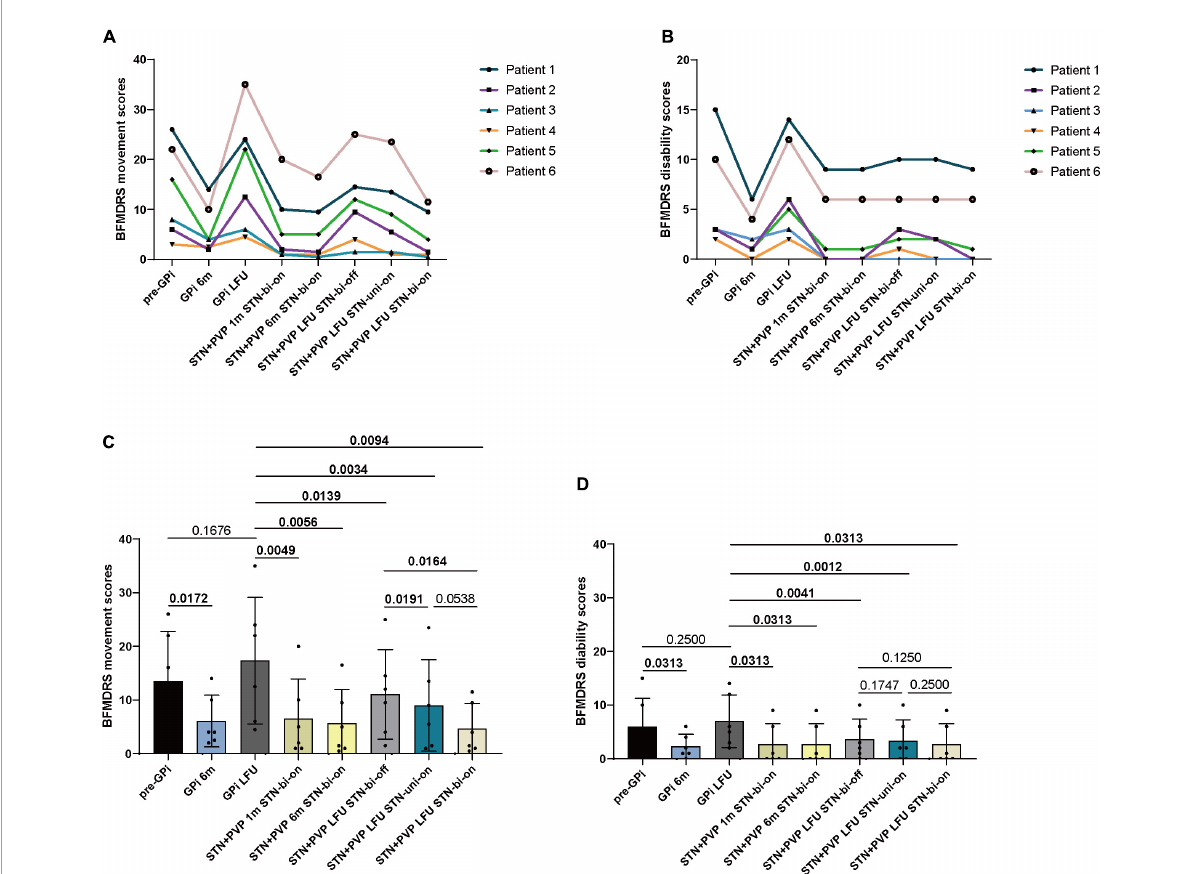
FIGURE2 Individual BFMDRS movement (A) and disability scores (B) before bilateral GPi DBS surgery (pre-GPi), at 6 months (GPi 6m) and the last follow-up (LFU) after GPi DBS (GPi LFU), and at 1 month (STN + PVP 1m STN-bi-on), 6 months (STN + PVP 6m STN-bi-on), and LFU post-bilateral STN plus unilateral PVP surgery. The LFU post-bilateral STN plus unilateral PVP was evaluated at three conditions: STN bilateral OFF (STN + PVP LFU STN-bi-off), STN unilateral ON (STN + PVP LFU STN-uni-on), and STN bilateral ON (STN + PVP LFU STN-bi-on). (C) Mean BFMDRS movement scores and (D) disability scores at each follow-up. LFU, last follow-up; m, month; Pre, pre-operation; PVP, posteroventral pallidotomy; bi, bilateral; uni, unilateral. P -values for comparisons between each follow-up are analyzed by parametric tests (Student paired-sample t -tests) or non-parametric models (paired-sample Wilcoxon signed-rank tests). A p -value of < 0.05 was considered statistically